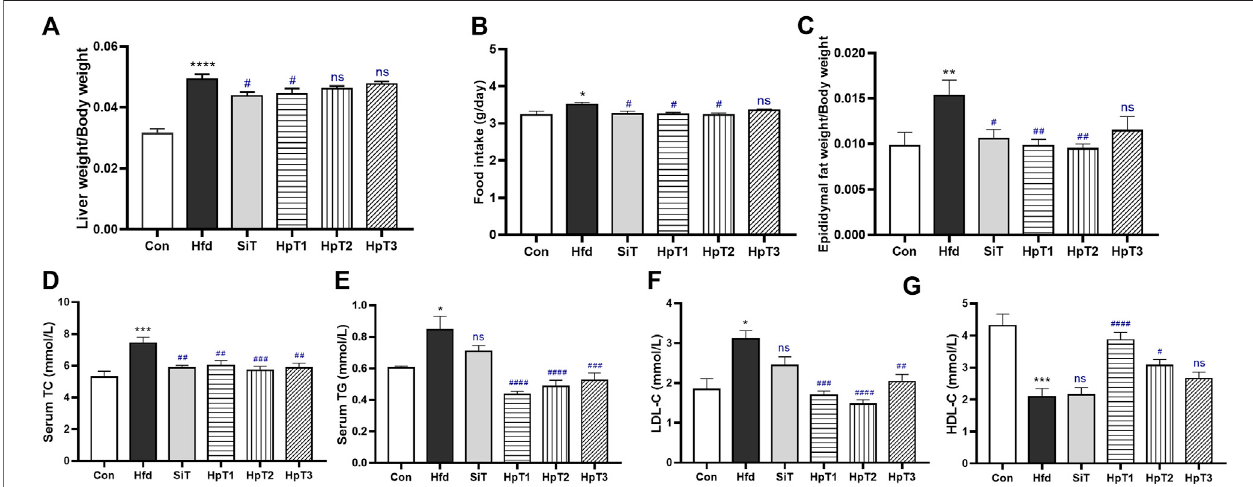
FIGURE2| HuangjiupeptidesT1andT2reducedepididymalfatweightgainanddecreasedserum TCandLDL-Cinhigh-fatinducedmice. (A) Liverindexand (B) foodintakewereexaminedamongmicegroups. (C) Levelofepididymal fatwasmeasured. (D) TC, (E) TG (F) LDL-Cand (G) HDL-Cofserum sampleswereassayedby biochemicalkits.Datawerepresentedasmean ± SEMofsixtoninemicepergroup.Unpairedtwo-tailed t testswereusedbetweenConandHfdgroups,andtheblack* was labelled on column with * p < 0.05, ** p < 0.01, *** p < 0.001, **** p < 0.0001. One-way ANOVA analyses were applied followed by Dunnett ’ s multiple comparisons test, and the signi fi cant p value of each group was compared with Hfd group. The blue # label indicated # p < 0.05, ## p < 0.01, ### p < 0.001, #### p < 0.0001, and ns means no signi fi cant differences.